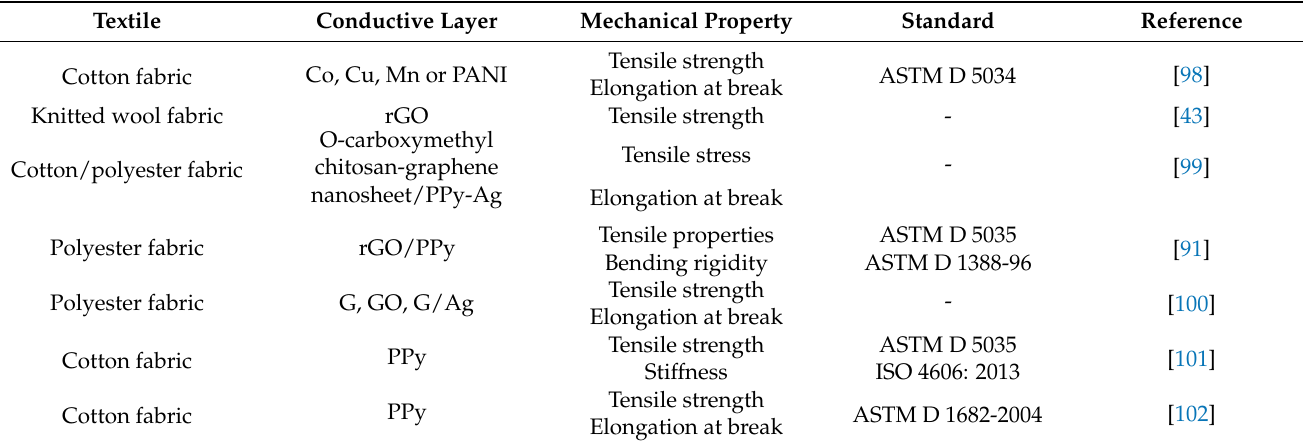
Table 4. Overview of mechanical properties’